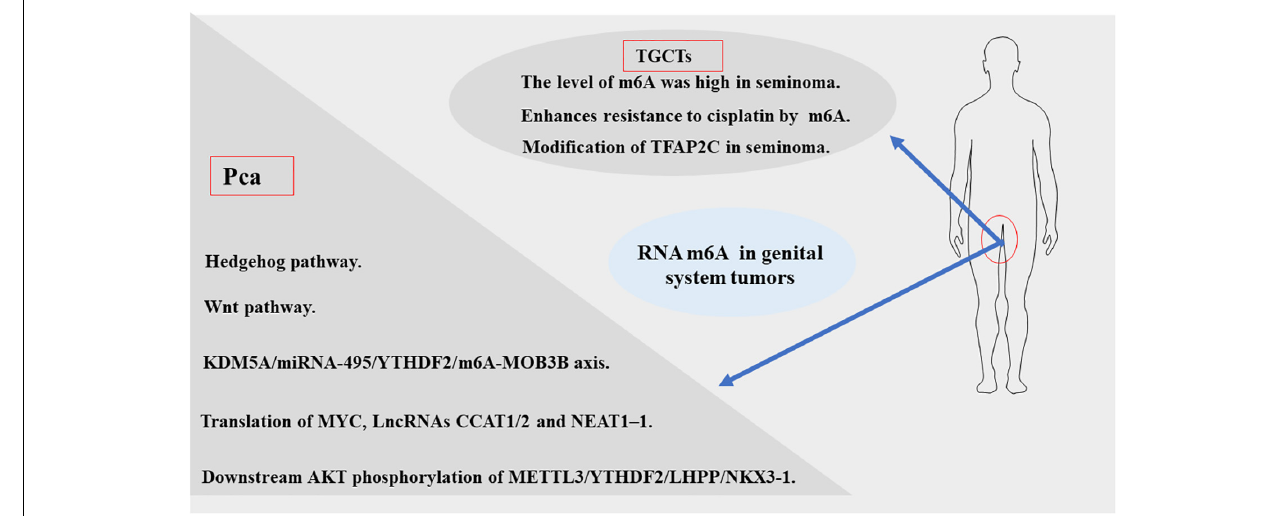
FIGURE 4 | The momentous biological pathways of m6A exertedin genital system